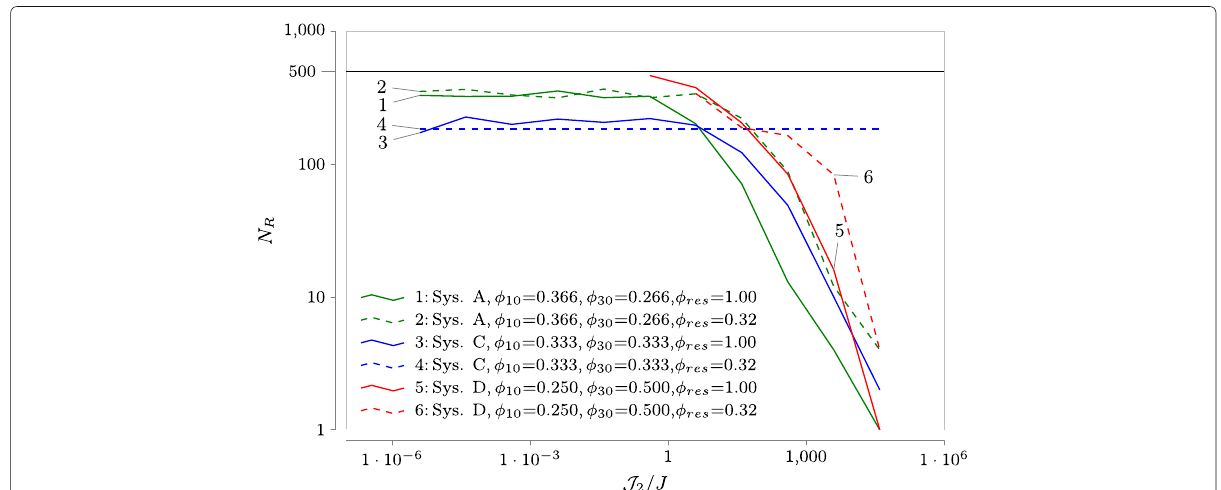
Fig. 4 Log-log plot of the number of consecutive iterations yielding realistic behavior ( N R ) versus the parameter value of J 2 for all three systems at two different values for φ 2, res , with J 3 / J = 5 ∗ J 2 / J . Notice the two regions with different performance as expected due to the influence of W ( t ) on v 3